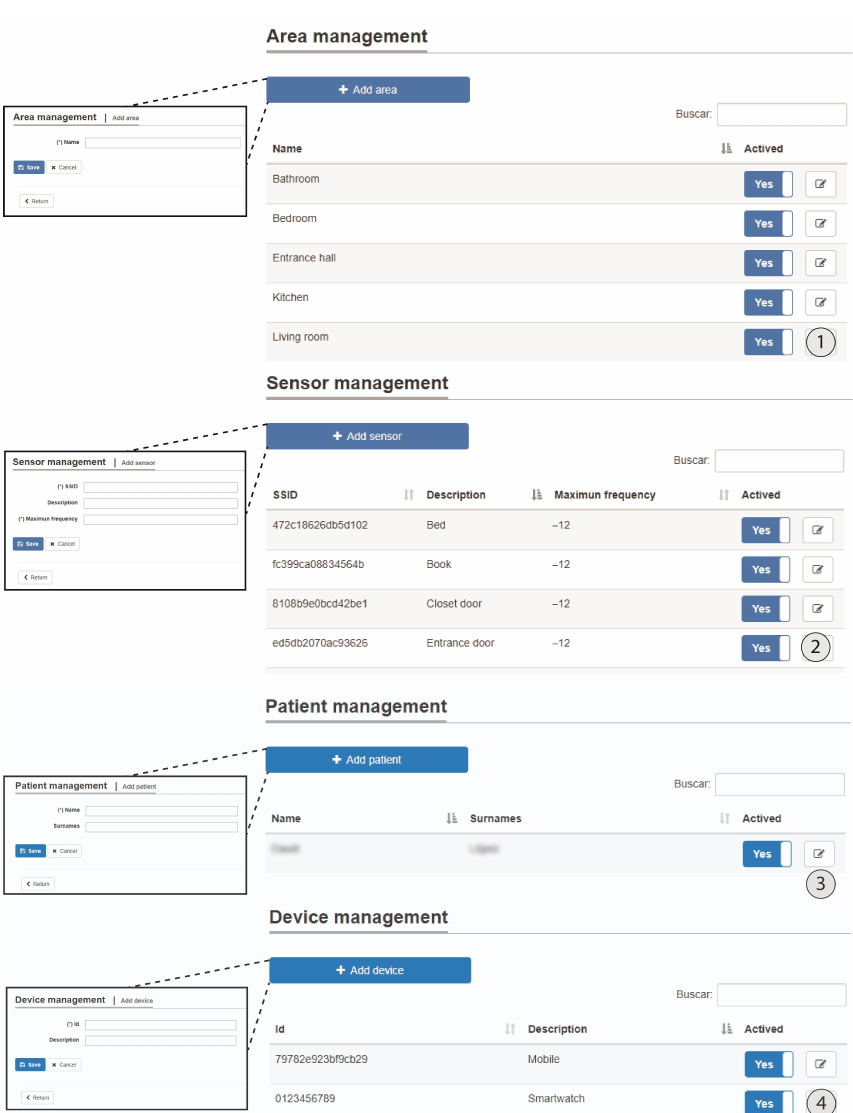
Figure 10. Management of different elements and data export and import.